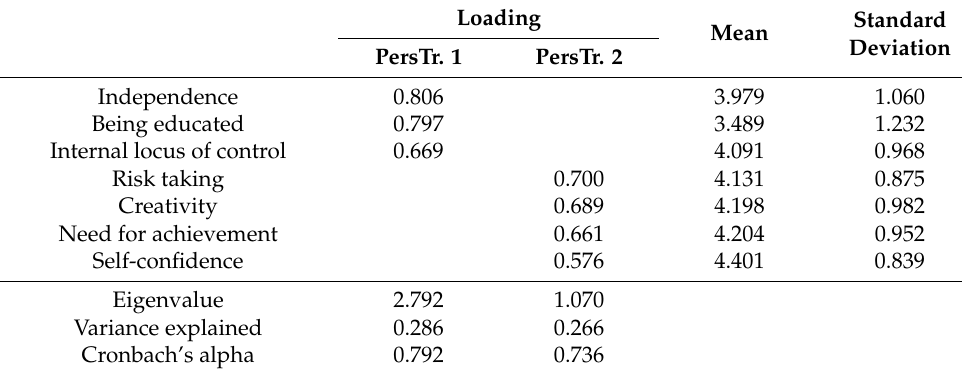
Table 3. Rotated component matrix: personality traits.